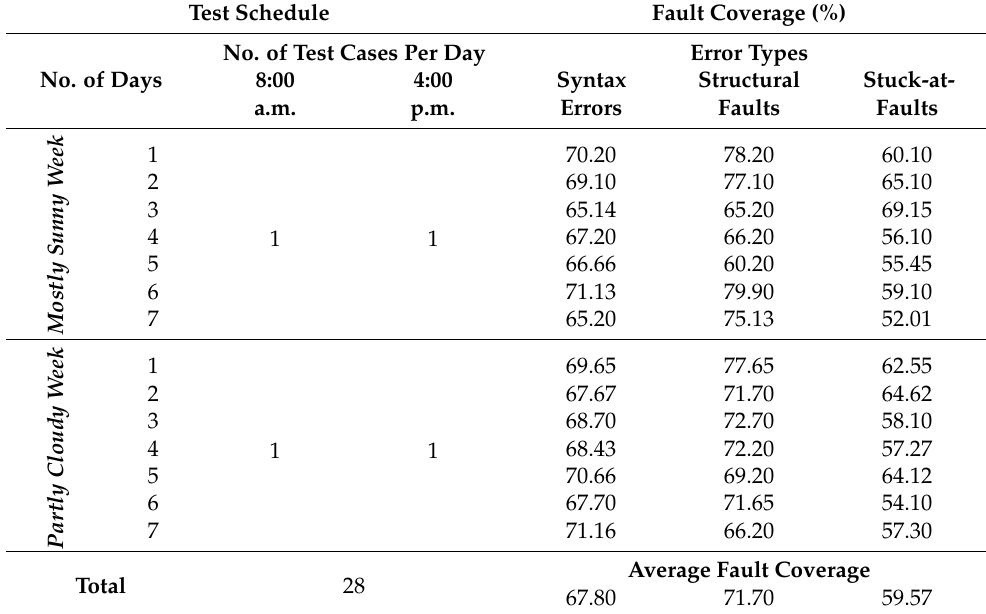
Table 1. Experimental results regarding our Hybrid Testing Suite (FPICT + JTAG)